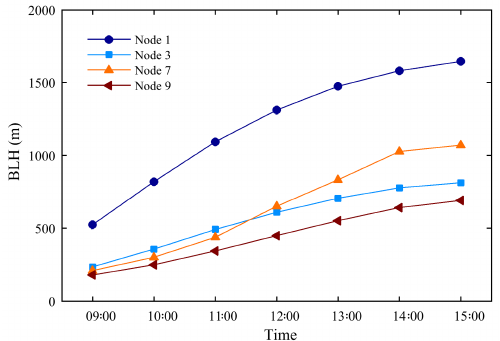
Figure 4. Daytime boundary layer height (BLH) estimated for the four typical ABL types (i.e., Nodes 1, 3, 7 and